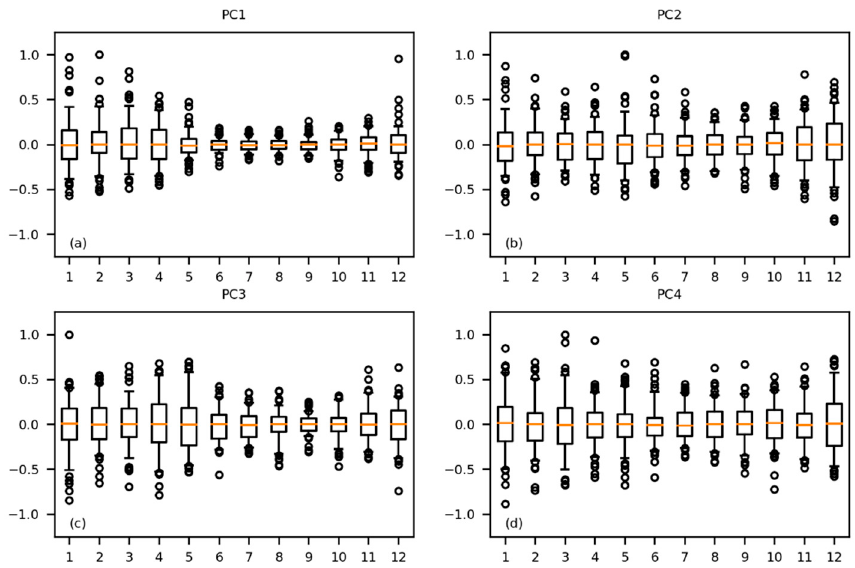
Figure 3. ( a ) Boxplot of the normalized magnitudes of PC1 month by month (horizontal axis); ( b ) Same but for PC2; ( c ) Same but for PC3; ( d ) Same but for PC4.